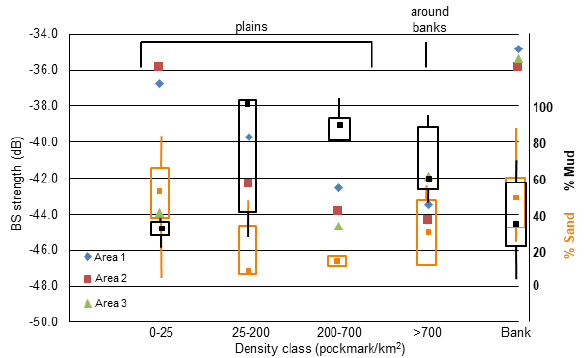
Figure 9. Sediment characteristics (box plots) and averaged seabed backscatter strength (coloured symbols) for each non ‐ scoured pockmark field density class per area. Similar results were observed for the scoured pockmark.